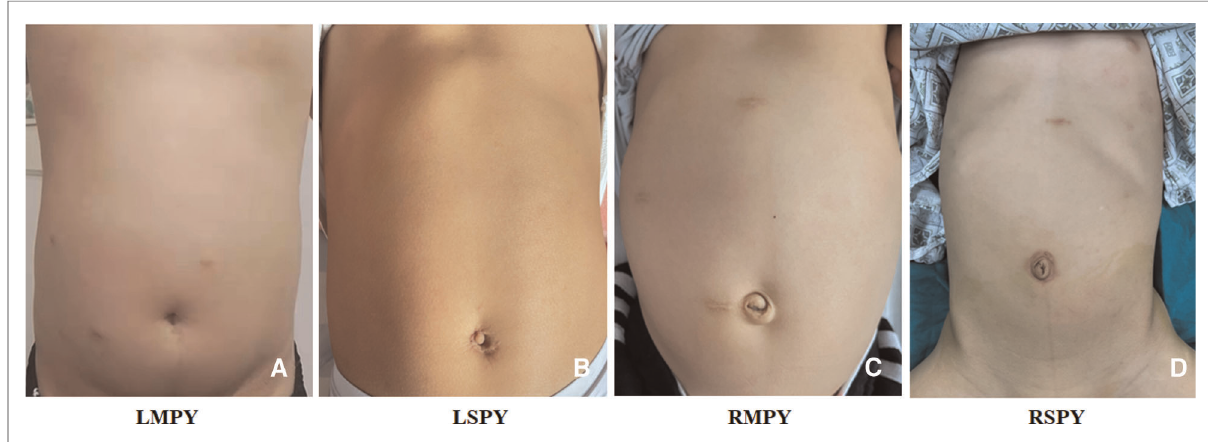
FIGURE 3 The cosmetic outcome of the surgical incision in each group. ( A ) LMPY, laparoscopic multiport pyeloplasty. ( B ) LSPY, laparoscopic single-port pyeloplasty. ( C ) RMPY, robot-assisted multiport pyeloplasty. ( D ) RSPY, robot-assisted single-port-plus-one